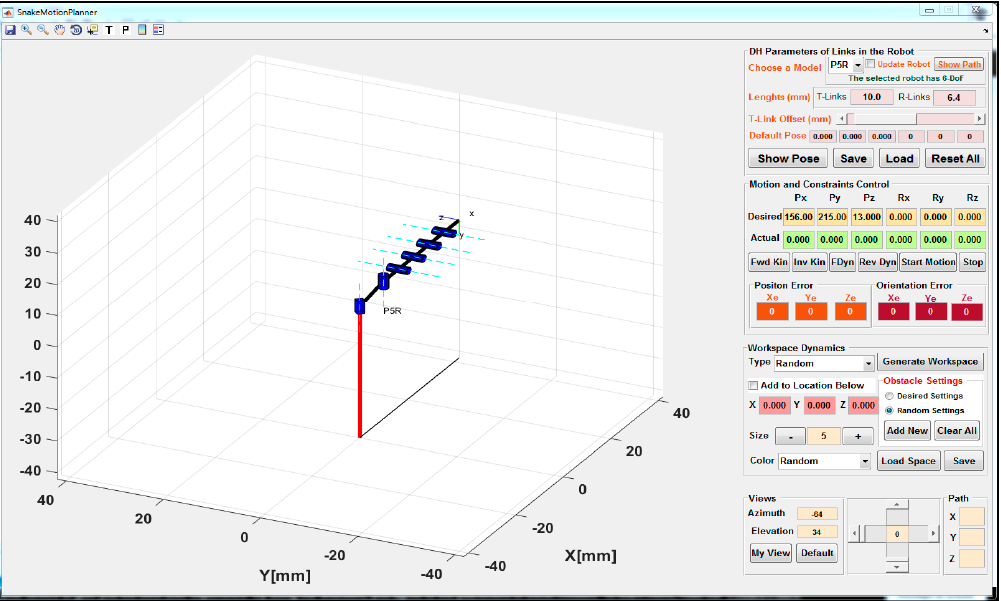
Figure 6. Default view of the motion control system.